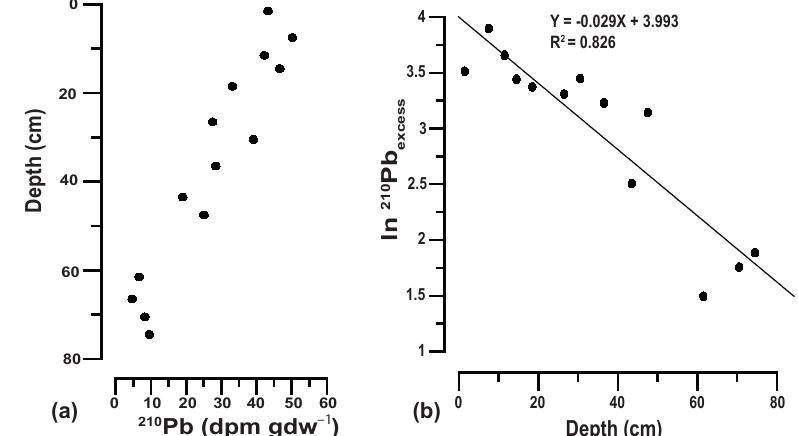
Figure 2. Variations in 210 Pb down the sediment core, (a) Depth profile of total 210 Pb activity downcore and (b) Correlation between depth and ln 210 Pb excess .